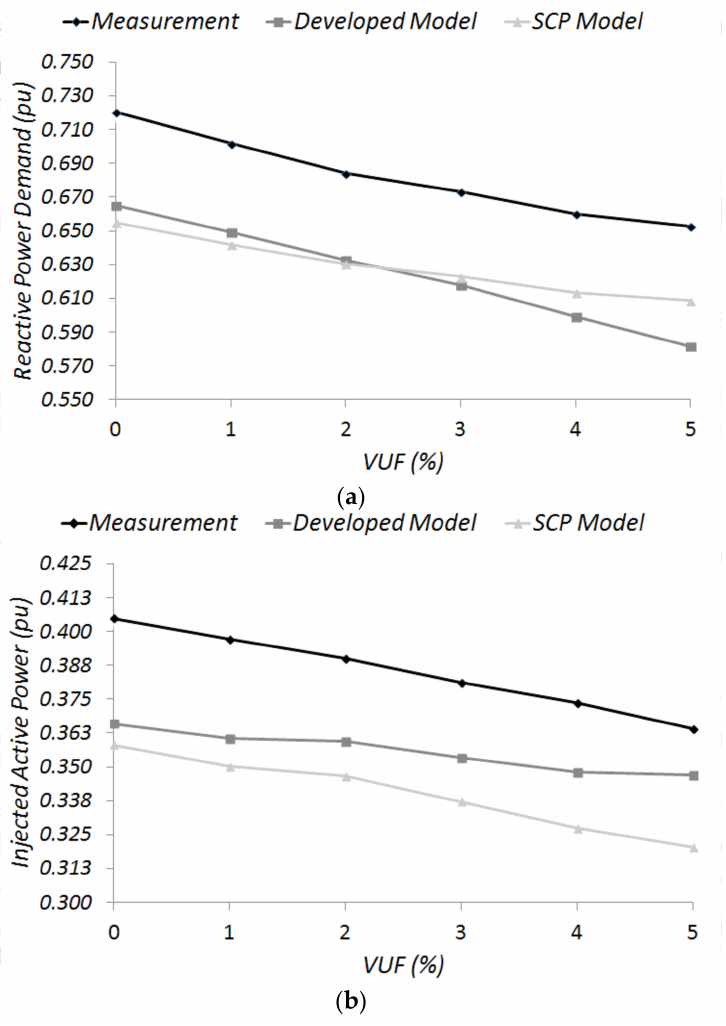
Figure 5. Variation of the reactive power demand ( a ) and injected active power ( b ) of the generator at the − 1.20% slip value for various unbalanced terminal voltages ( VUF